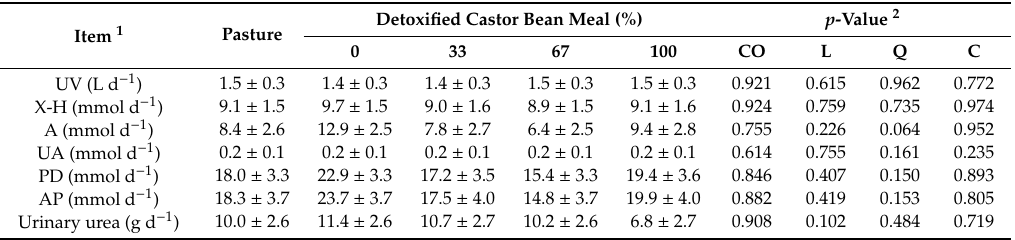
Table 8. Urine parameters of lambs (mean ± SD) supplemented with or without castor bean meal via a creep-feeding